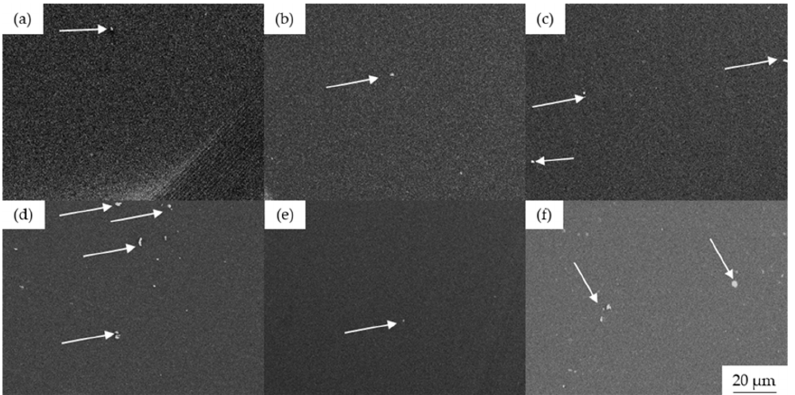
Figure 7. SEM images of cross-sectioned PLA and master batch granules: ( a ) pure PLA, ( b ) A5, ( c ) B5, ( d ) G5, ( e ) P5, and ( f ) Y5. Arrows indicate the position of